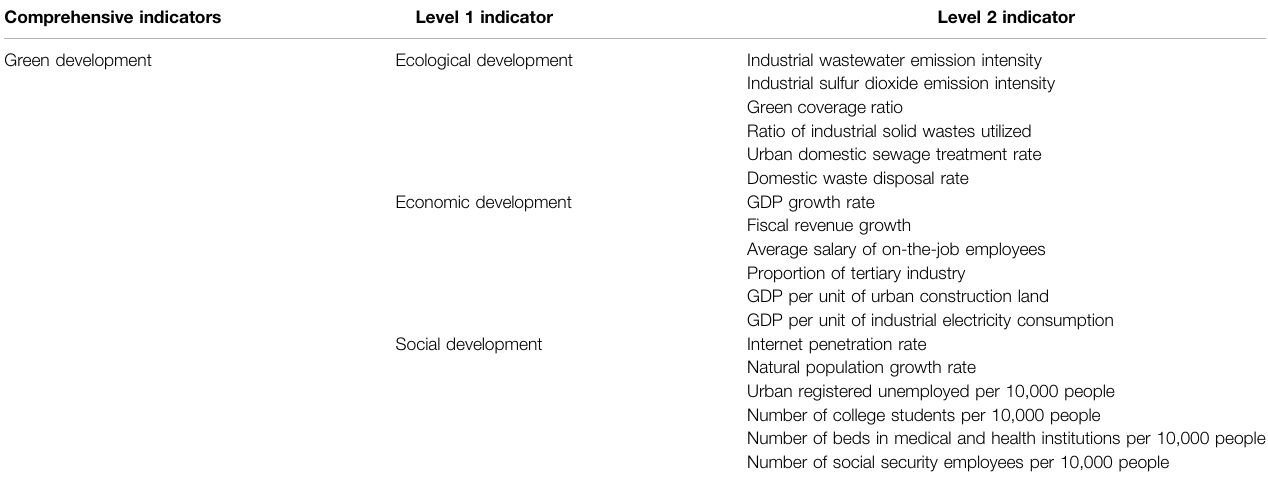
TABLE 1 | Evaluation system of green development. Comprehensive